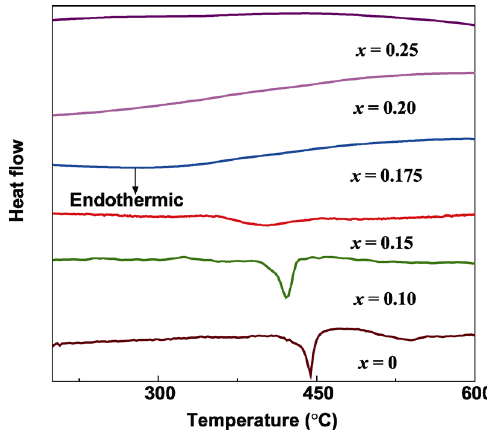
Fig. 4 DSC plots of Bi 2 V 1– x Al x /2 Ti x /2 O 5.5– δ (0 ≤ x ≤